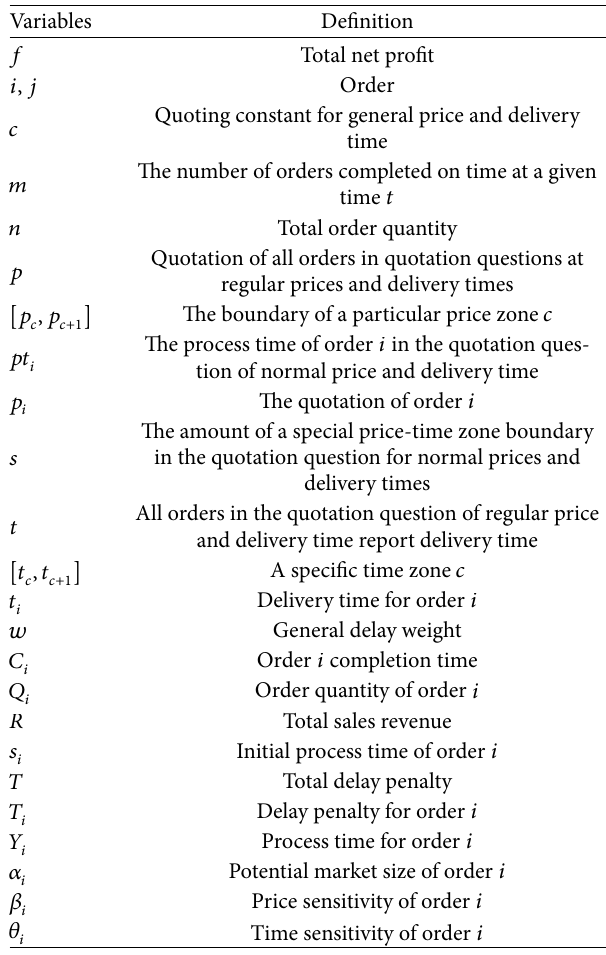
Table 1: Variable symbol